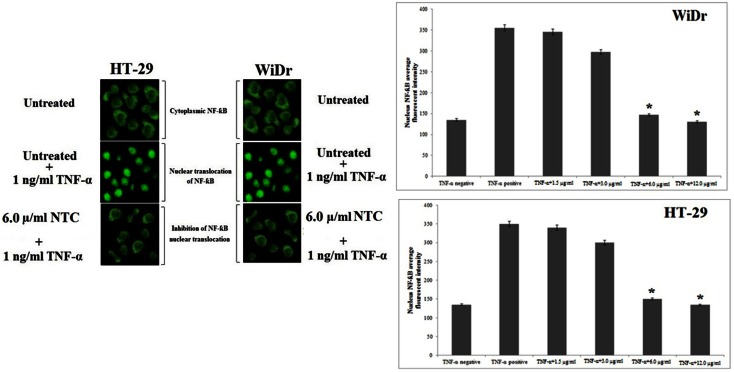
Translocation of NF-κB. After treatment of both cancer cells by several concentration of NTC for duration of 3 h, the cells were exposed for 30 min to TNF- α (1 ng/ml). Results disclosed no significant cytoplasmic to nucleus translocation of NF-κB. All data were expressed as the means ± standard error of triplicate measurements. *P < 0.05 compared with the no-treatment group.